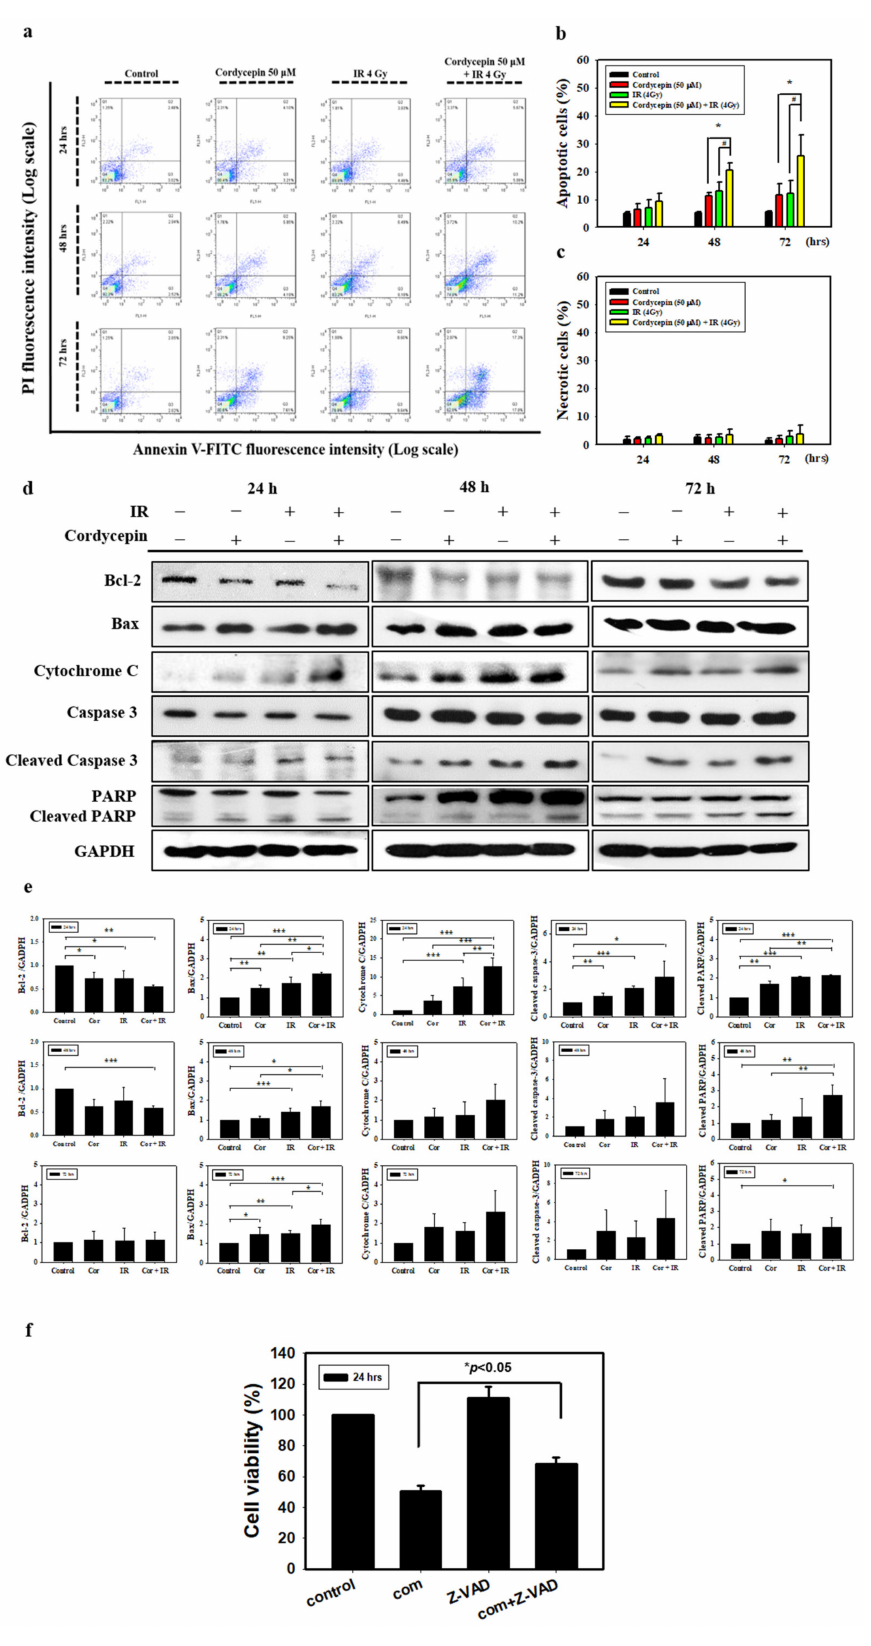
Figure 2. Measurement of apoptosis in SAS cells receiving various treatments. ( a ) SAS cells were treated with cordycepin and / or IR for the indicated times and stained with annexin V and propidium iodide (PI). Flow cytometry was used to determine the fractions of viable cells (annexin V − , PI − ;